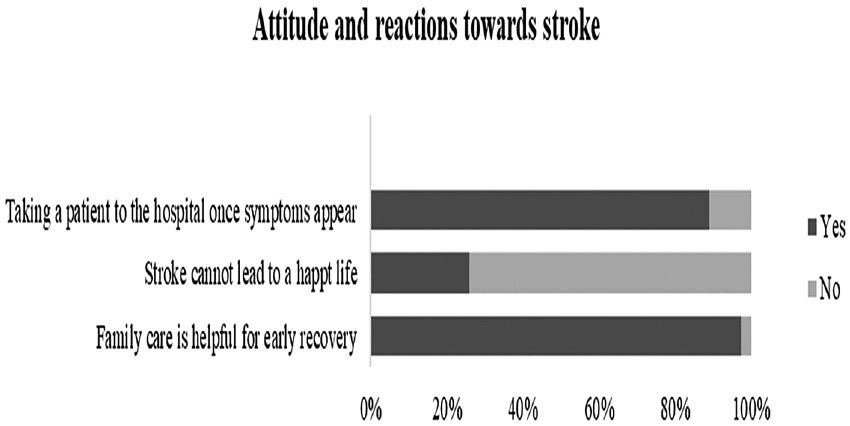
Figure 5. Knolwedge, attitude, and reactions of the participants towards